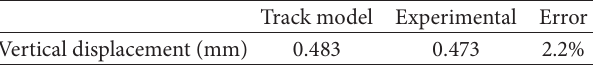
Table 4: Uncracked track model